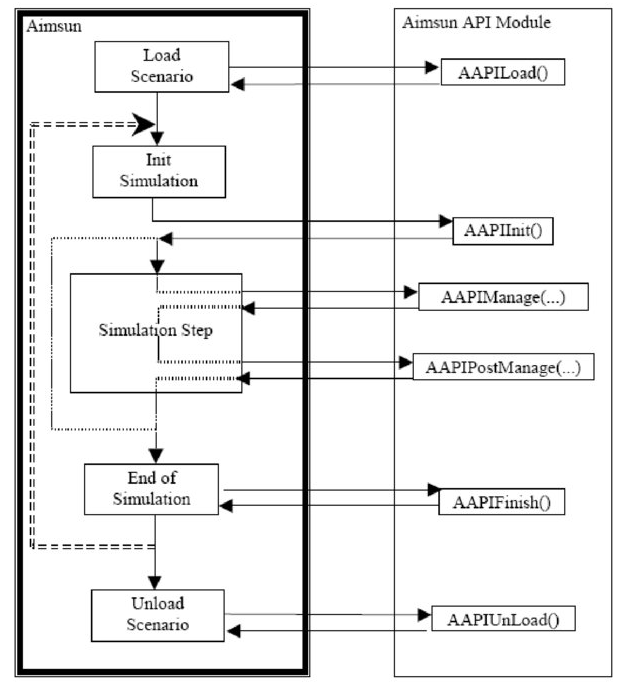
Figure 10. Aimsun Next and API Module interaction